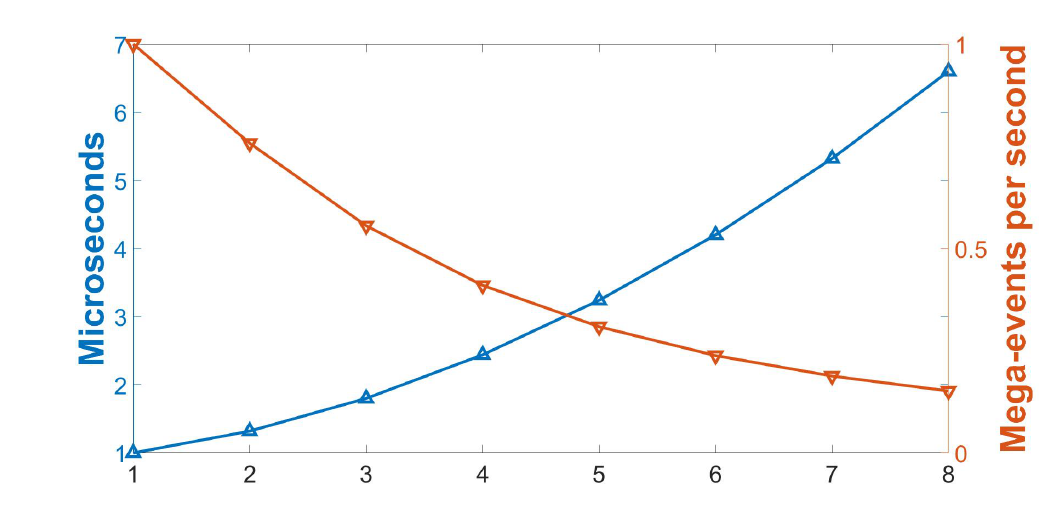
Figure 11. Left axis : Processing time per event with different radii. Right axis : Evolution of mega-events per second for each different